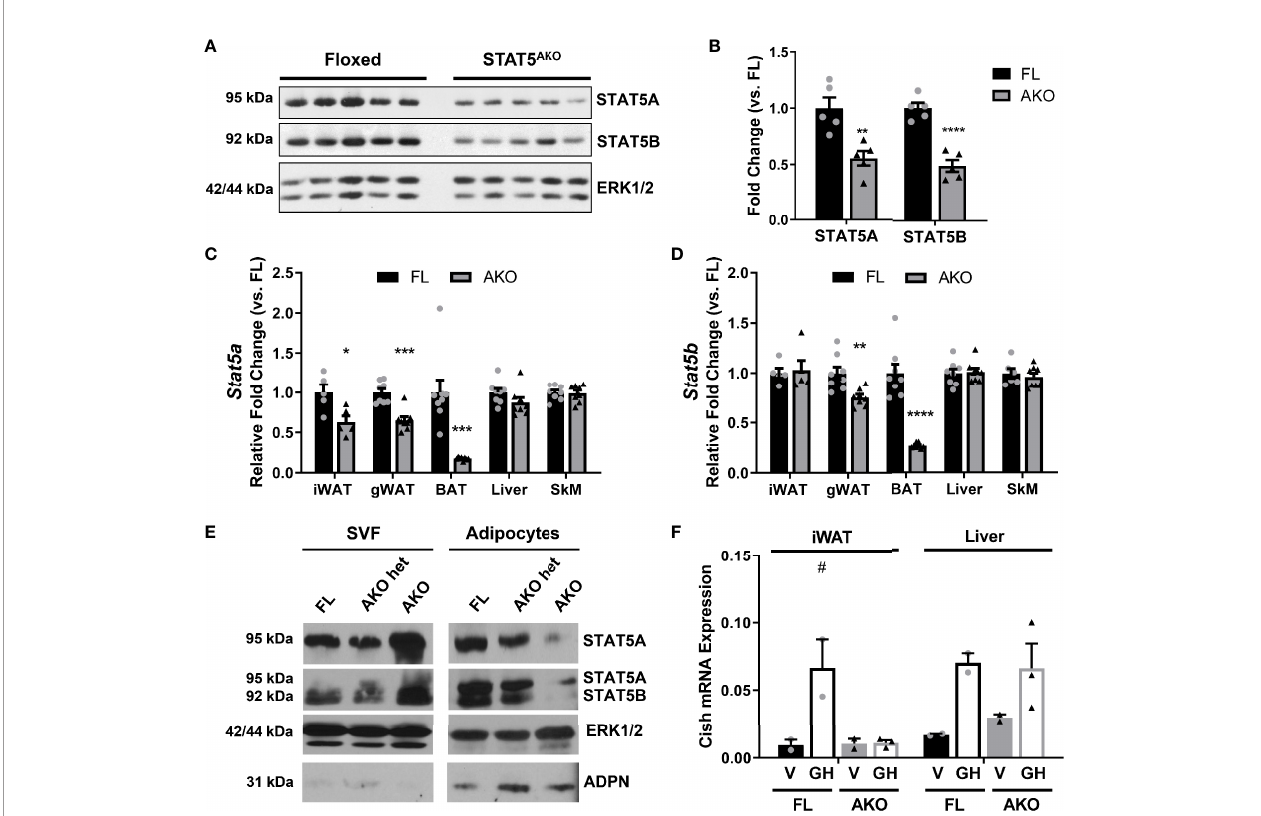
FIGURE 1 | Expression of STAT5A and 5B is knocked down in adipose tissue and adipocytes of STAT5 AKO female mice. Female STAT5 AKO (AKO) mice and their fl oxed (FL) littermate controls were euthanized at 3 (A – D) , 4 (E) , or 11 (F) months of age, and tissues were immediately collected for protein or gene expression analyses (A – D, F) or cellular fractionation (E) . (A) Immunoblot of proteins resolved from iWAT samples for 5 mice of each genotype. (B) Quanti fi cation of band intensities from A (n = 5 per group). Band intensities were normalized to the loading control ERK1/2 and represented as fold change relative to FL mice. (C, D) Stat5a and Stat5b gene expression measured by RT-qPCR for the indicated tissues (n = 5 – 8 mice per group). (E) Gonadal white adipose tissue was removed from female STAT5 AKO , heterozygous STAT5 AKO (het AKO), and homozygous fl oxed control (FL) mice, fractionated into adipocytes and stromal vascular fraction (SVF), and 100 µg (SVF) or 200 µg (adipocyte) protein subjected to western blotting. Also shown are ERK1/2 as a loading control and adiponectin (ADPN) as an adipocyte marker. For each protein, the SVF and adipocyte samples were run on the same gel and the images were from the same exposure of the same blot. (F) Eleven-month-old female mice were injected with 1.5mg/kg mGH or vehicle (V; 0.1% BSA/PBS) for 30 minutes prior to euthanasia and tissue collection. Cish gene expression measured by RT-qPCR is shown (n = 2 – 3 mice per group). Signi fi cance was determined by t -test for FL versus AKO comparisons in A-D) and is denoted as *p < 0.05, **p < 0.01, ***p < 0.001, ****p < 0.0001. For F, a 2-way ANOVA was used to assess treatment/genotype and tissue variables with Tukey ’ s post- hoc multiple comparisons test to compare all treatment/genotype groups for each tissue; # denotes p < 0.05 for GH versus V comparisons. See also Figure S1